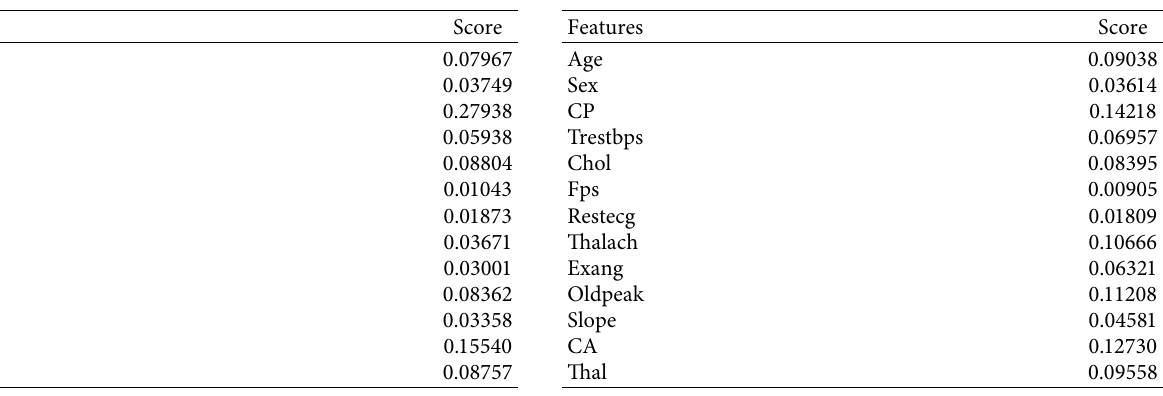
Figure 4: Important features extracted by LDA. Table 2: The score of all features by PCA FE. Table 3: Score of all features by